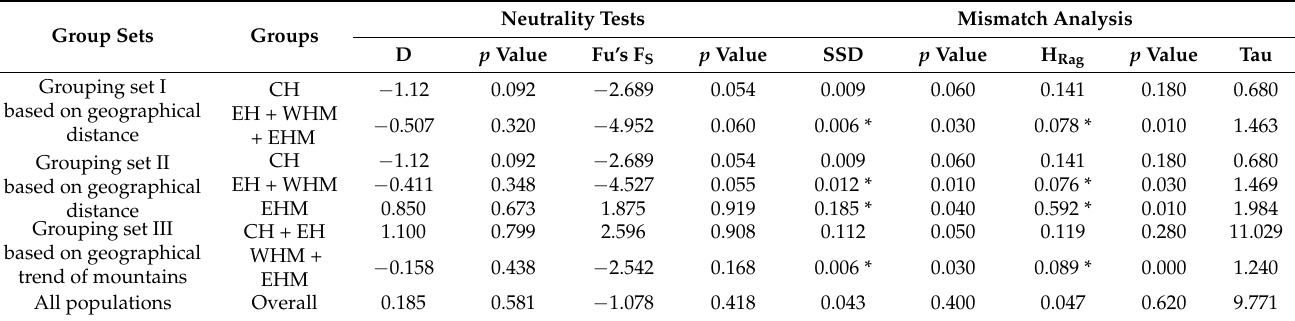
Table 3. Results of neutral test and mismatch analyses of groups. Populations were divided into six basic groups in three ways based on geographical distance and the trend of mountains: CH from the central Himalaya, EH + WHM + EHM from the eastern Himalaya plus the Hengduan Mountains, CH + EH from the Himalaya, WHM + EHM from the Hengduan Mountains, EH + WHM from the eastern Himalaya plus the western Hengduan Mountains, and EHM from the eastern Hengduan Mountains. Tajima’s D represents the site-frequency spectrum for single-nucleotide polymorphism loci; Fu’s Fs represents the deviation from neutral expectation in populations; HRag and SSD are both used to evaluate the sudden expansion model of unimodal distribution, and tau ( τ ) represents the unit of mutational time of unimodal distribution; * = p < 0.05.